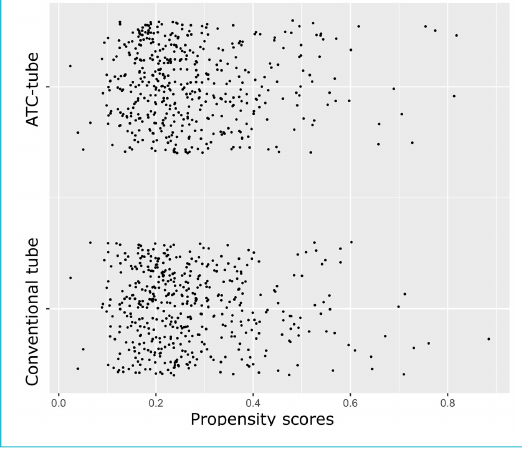
Figure 2: Lineplot of the absolute standardised differences of all individual covariates before and after propensity score matching. The standardised differences of all individual covariates after propensity score matching was <0.1, except for weight (0.43) and body mass index